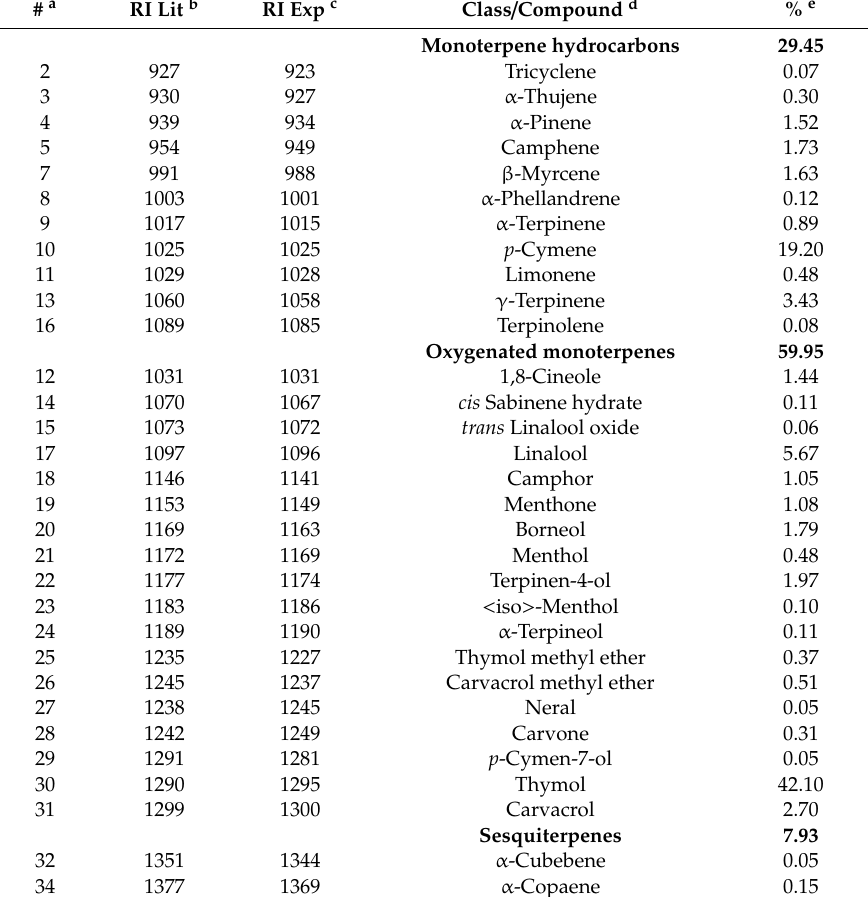
Table 1. Chemical composition of commercial Thymus vulgaris essential